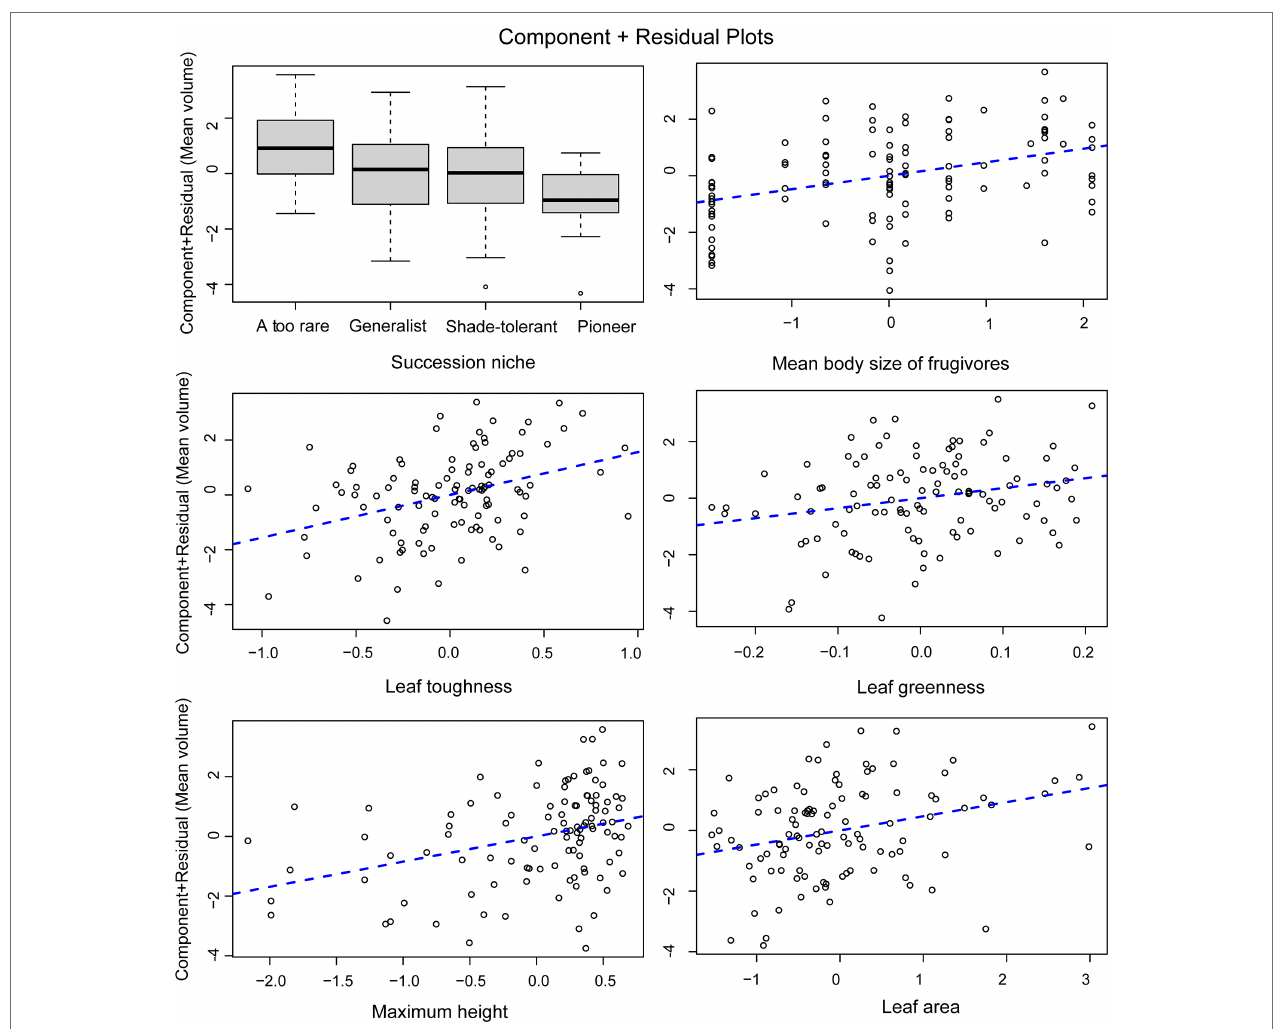
FIGURE 6 | Component residual plots for the main effects in the multiple regression model. Points represent mean seed volume when all factors are held at their median values (partial residuals) and regression lines are derived from the multivariate regression